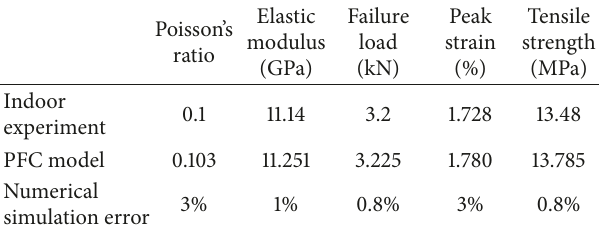
Table 5: Comparison between the mechanical parameters of indoor experiment and PFC model.